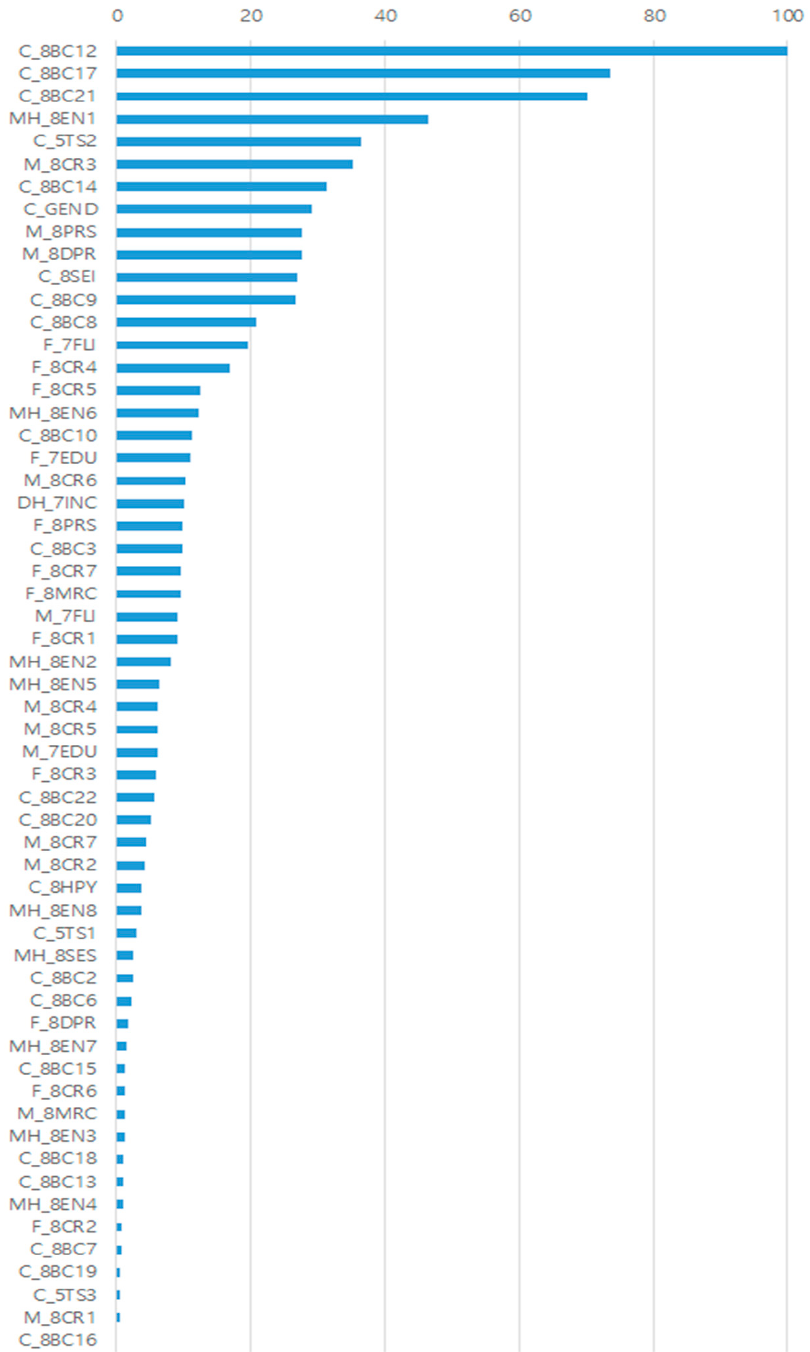
Figure 7. The relative importance of input variables. Assuming that the contribution of the variable with the highest contribution to the prediction is 100, the contribution of the remaining variables is expressed as a relative ratio.